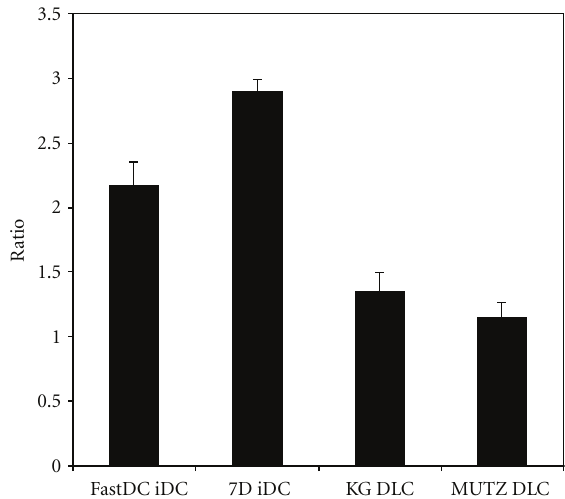
Figure 4: Dextran uptake of immature DC from PBMC and DLC di ff erentiated from KG-1 and MUTZ-3 cells. Dextran uptake of each sample was detected by flow cytometry after 1 hr of incubation at 37 ◦ C or on ice and MFI ratio is presented. Tests were carried out in PBMC on day 1 of FastDC (FastDC iDC) and day 5 of 7-day culture (7D iDC), as well as di ff erentiated DLC from KG-1 (KD DLC) and MUTZ-3 cells (MUTZ DLC) via FastDC culture and 7- day culture, respectively. Results are shown as mean ± SEM, at least three samples were tested.